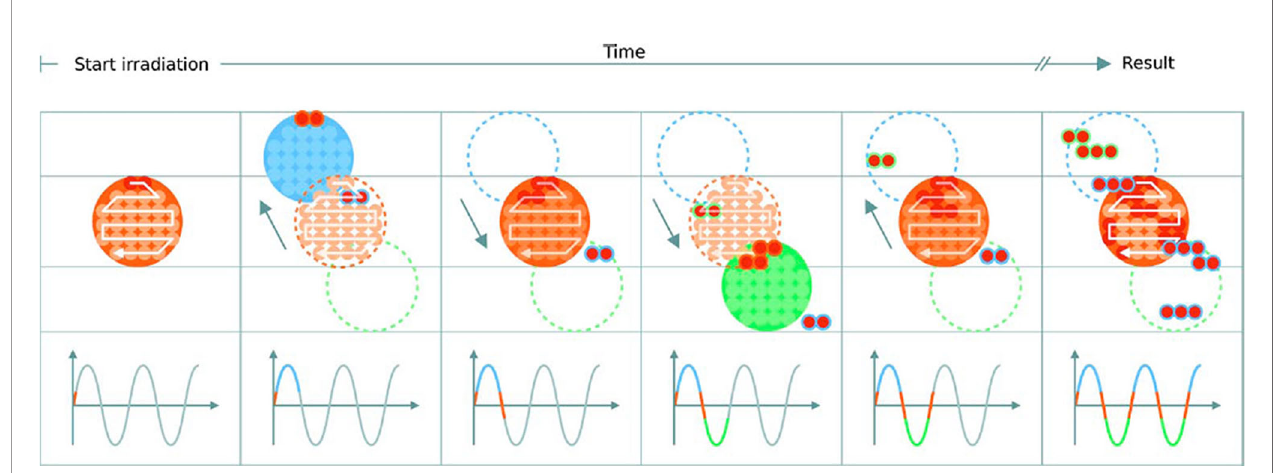
FIGURE 10 | Delivery of a single IES with target motion (phases of movement are indicated by the plot and shown in blue, orange and green). The initially determined scan path in the target volume is shown in red. The raster scanned spots are translated outside the target due to motion which results in progressive degradation of the dose distribution. Reproduced from (124) with permission from